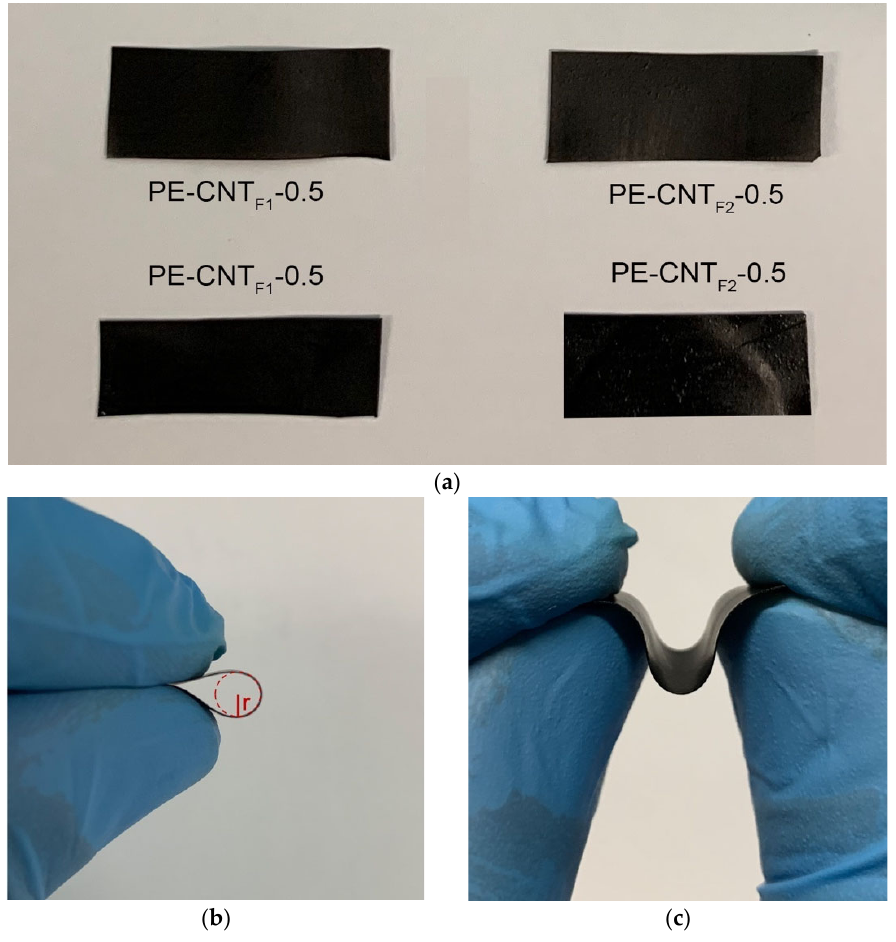
Figure 1. ( a ) Four samples of flexible CNT ‐ filled ultra ‐ high molecular weight PFPE ‐ functionalized electrodes. In figure ( b ), the electrode is bent until reaching a bent radius of 2 mm, while in figure ( c ), the flexibility of the PE ‐ CNT F2 ‐ 5 electrode is displayed.